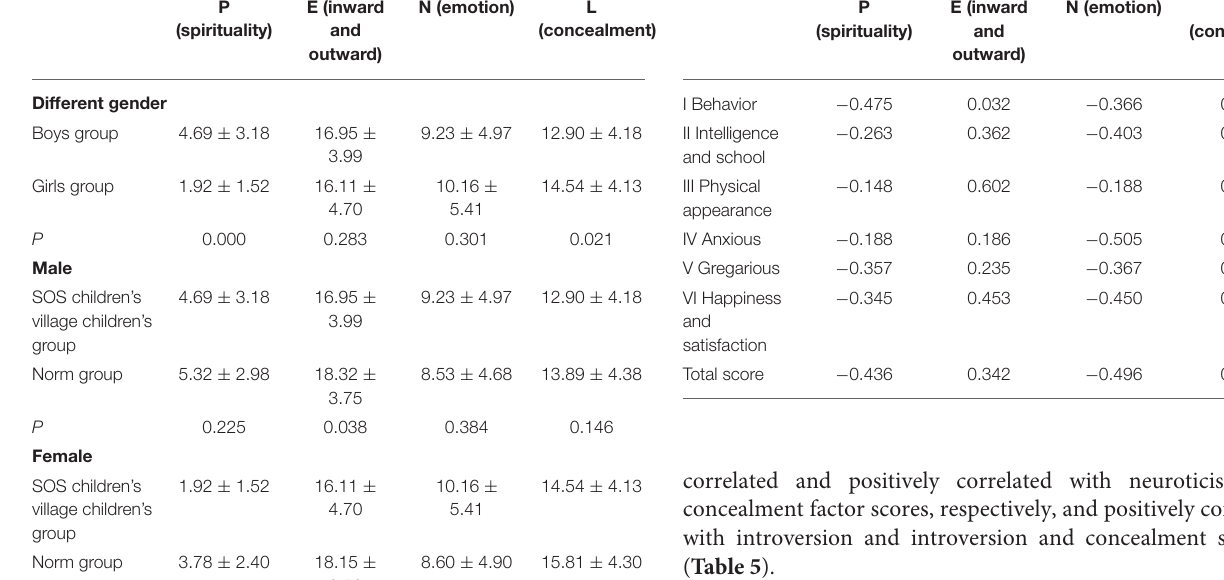
TABLE 5 | Results of correlation analysis between self-awareness and EPQ scales and children’s general situation ( n